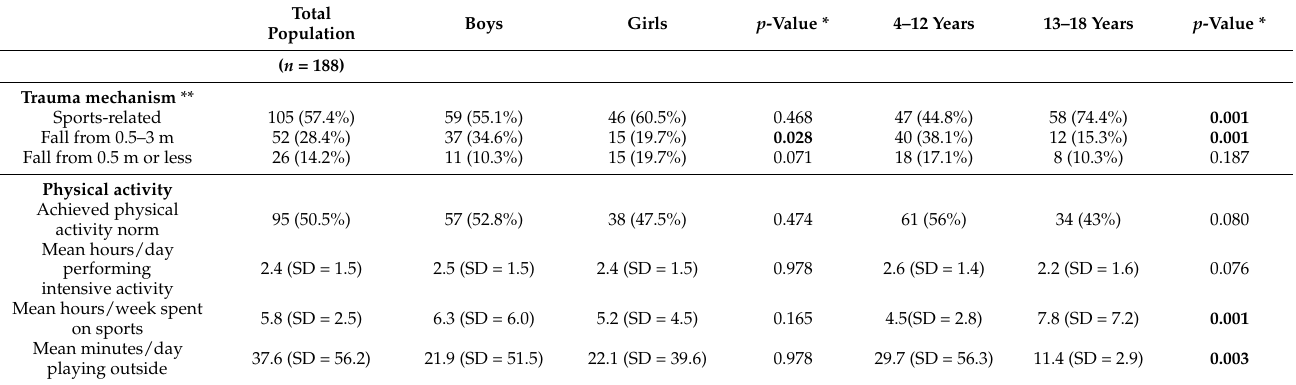
Table 3. An overview of the study population’s physical activity and trauma mechanism causing fractures.